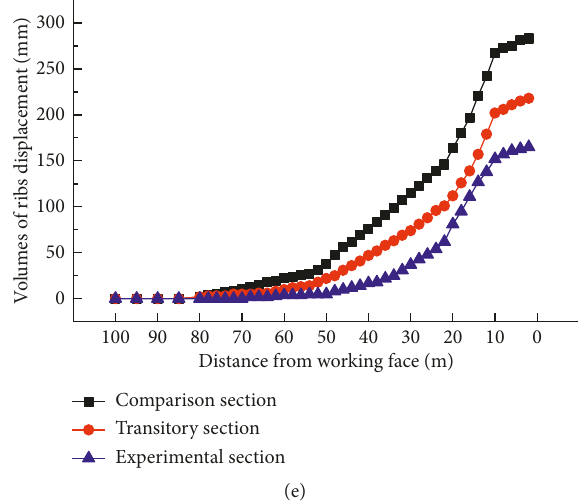
Figure 17: Monitoring on the site: (a) layout of the monitoring points. Monitoring curves of (b) the working resistance in the upper station, (c) the floor heave, (d) the roof subsidence, and (e) the rib